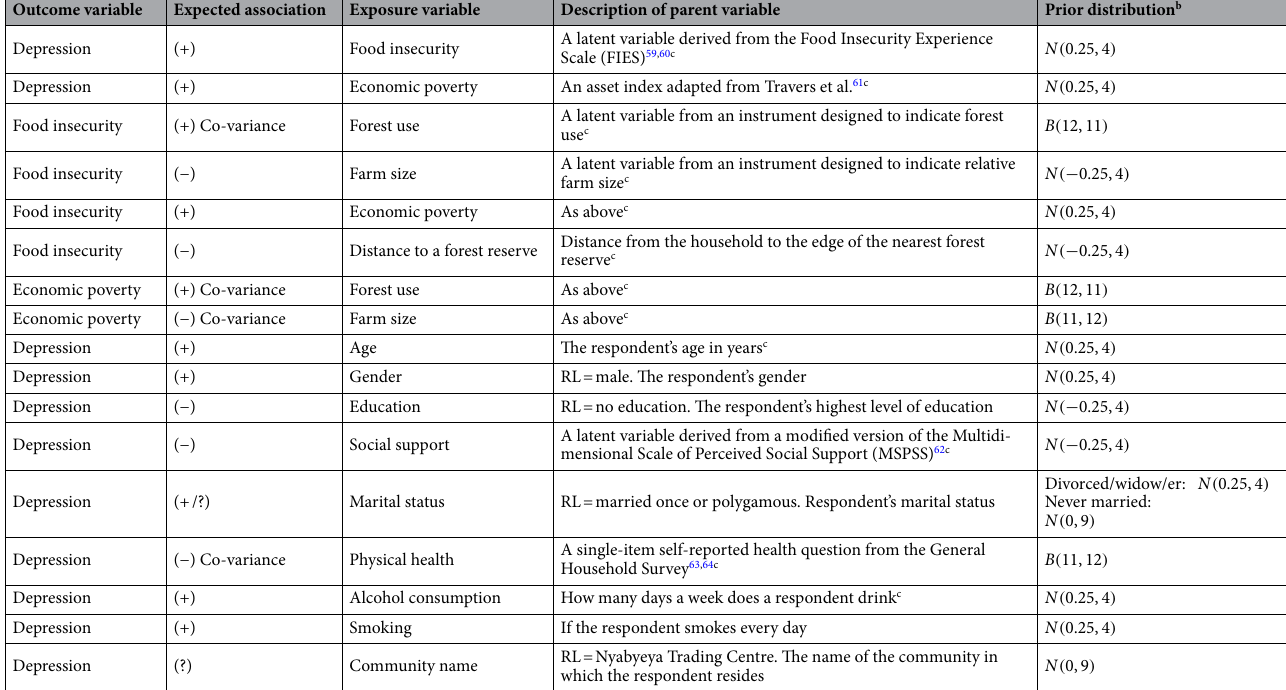
Table 2. The a priori hypothesised associations between exposure and outcome variables in the structural equation model and a description of the exposure variables. a a Key: ‘+’ = positive association; ‘−’ = negative association; ‘?’ = uncertain direction of the association; RL = reference level, N = normal distribution (where the first argument is the mean and the second is the variance), B = beta distribution (with the arguments indicating the first and second shape parameters). All continuous variables are scaled and centred. b See SM 3: Prior probability details for evidence supporting each prior. c These variables are scaled and centred, and are thus presented in units of standard